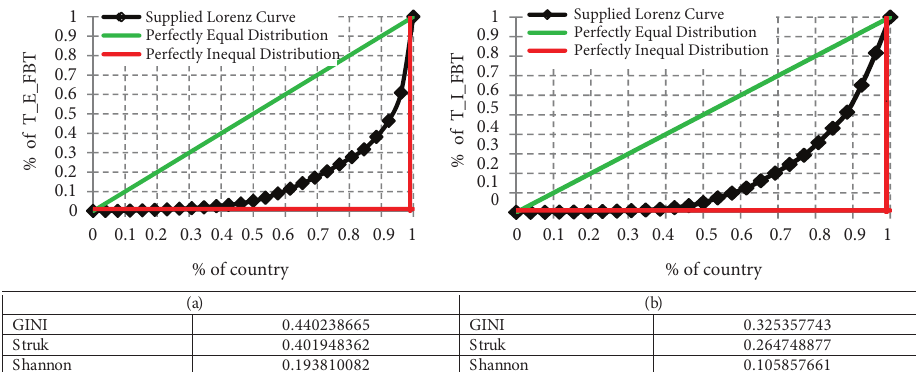
Figure 5. Concentration graph of Total exports (a) and Total imports (b) of Food, beverages and tobacco of Romania in EU, cumulated values, 2007–2016 (source: authors’ own